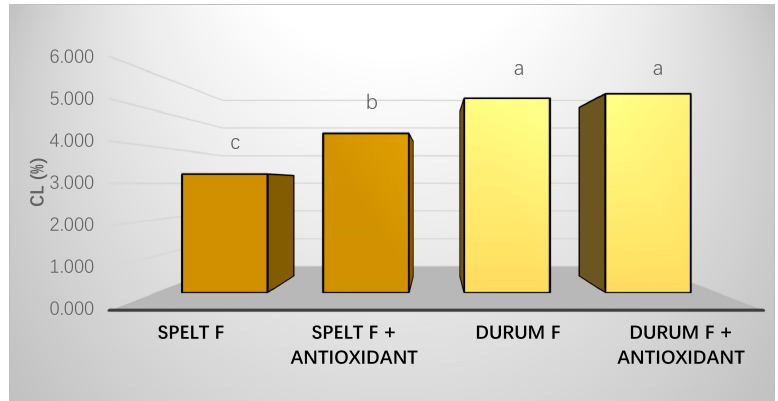
Figure 5. Cooking losses (%) for both types of pasta. Distinct letters indicate significant difference ( p < 0.05) among each formulation. Two types of pasta are shown in different colors.